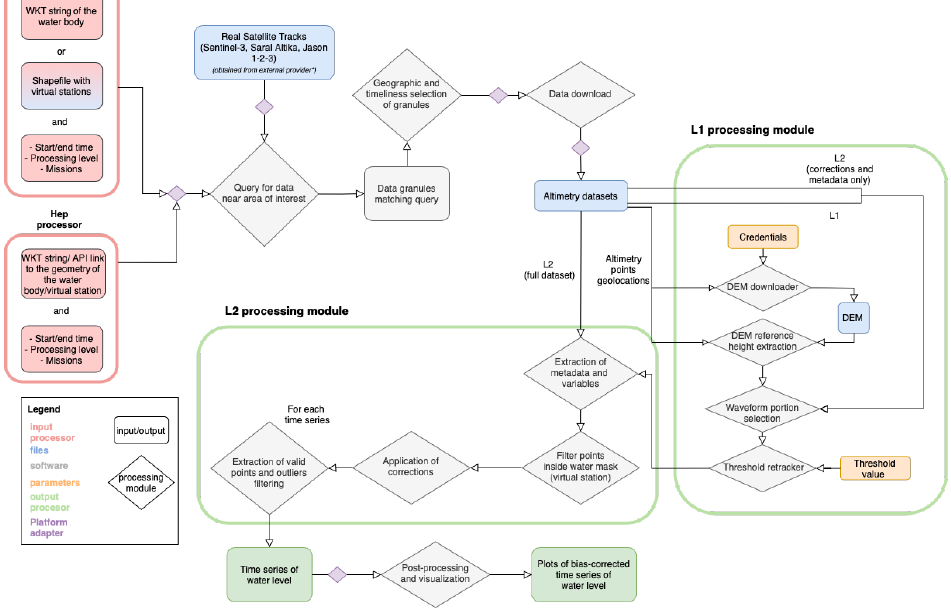
Figure 3. Water level processor teroWAT diagram